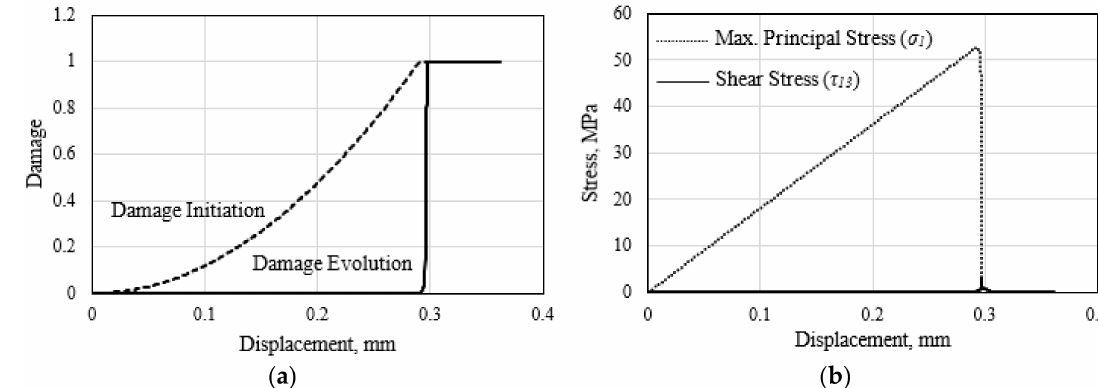
Figure 7. ( a ) Damage initiation and evolution to separation, and ( b ) the corresponding stresses at the critical material point of the cell wall of the HC